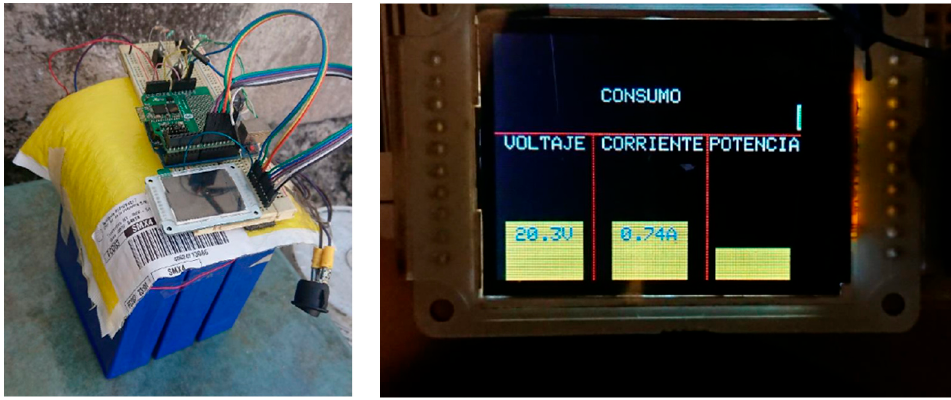
Figure 3. Low − cost solar station for on-campus irradiation measurement.